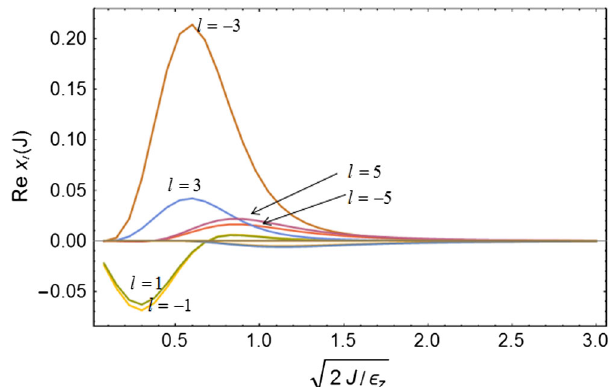
ð J Þ of the most unstable l ¼ 0 . 546 , N ¼ N FIG. 11. Growth rate vs horizontal tune with longitudinal 0 . x impedance (ZL). The red and blue points represent the σ and π modes,